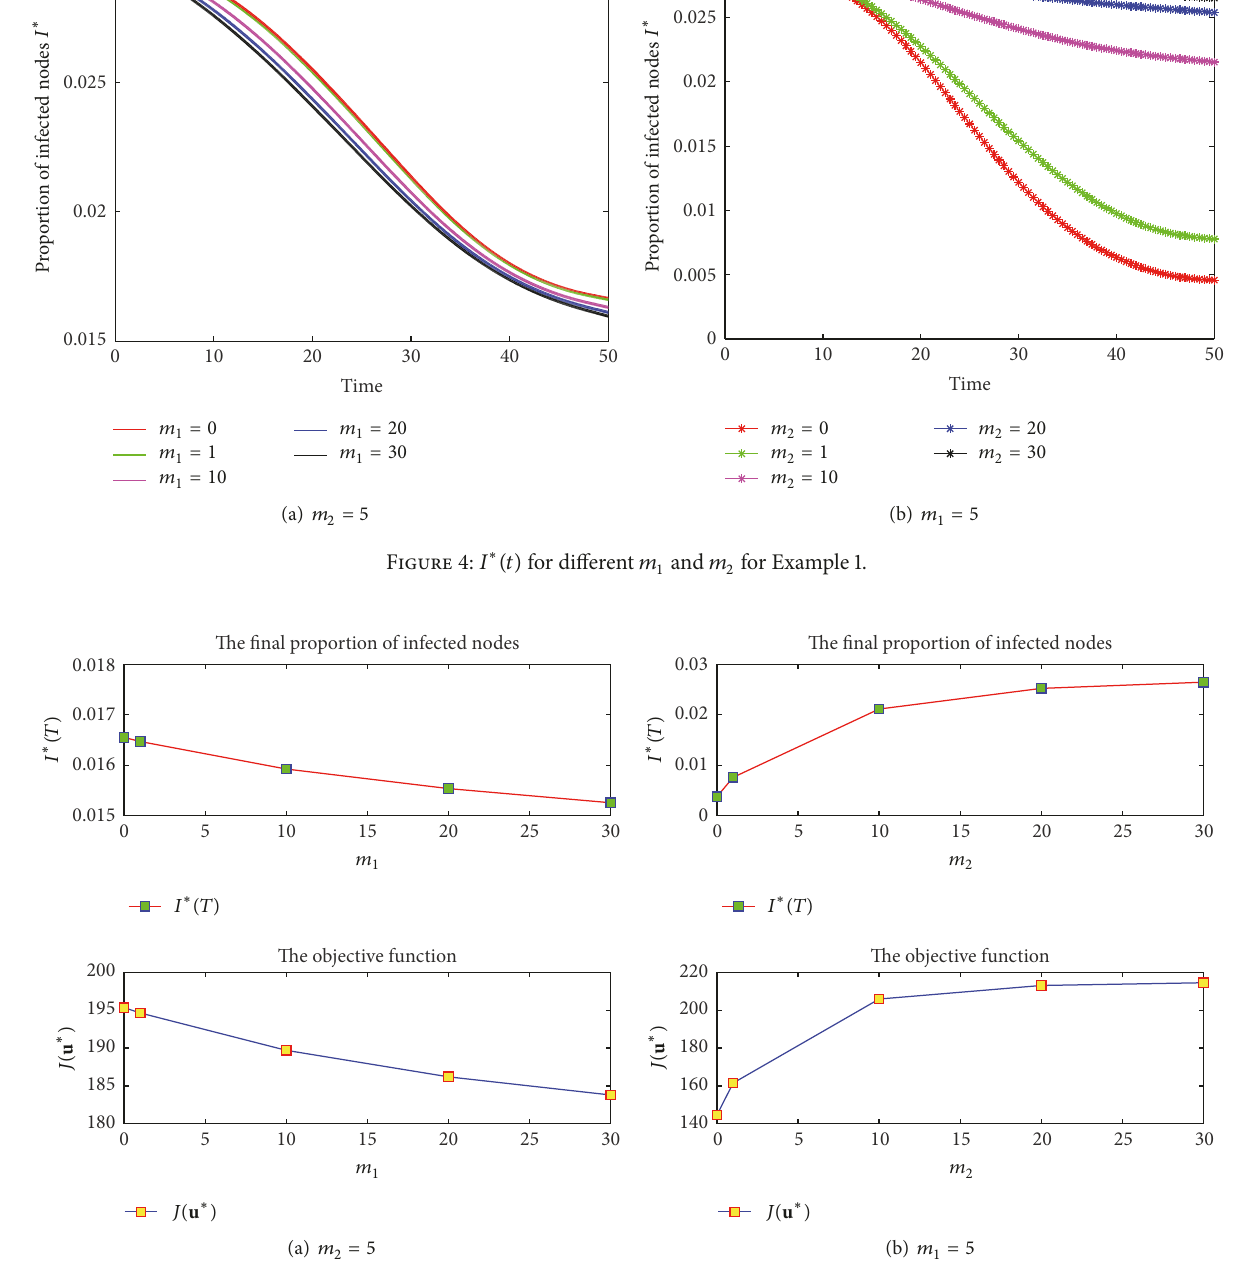
Figure 5: The final proportion of infected nodes 𝐼 ∗ (𝑇) and the objective function 𝐽( u ∗ ) for different 𝑚 1 and 𝑚 2 for Example